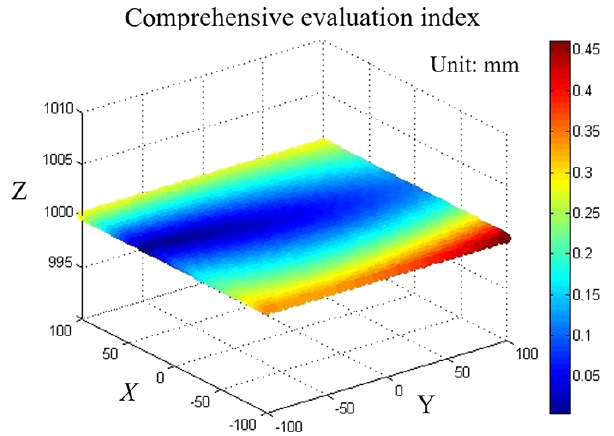
Figure 13. When z = 1000mm, the influence of position error caused by posture-error.